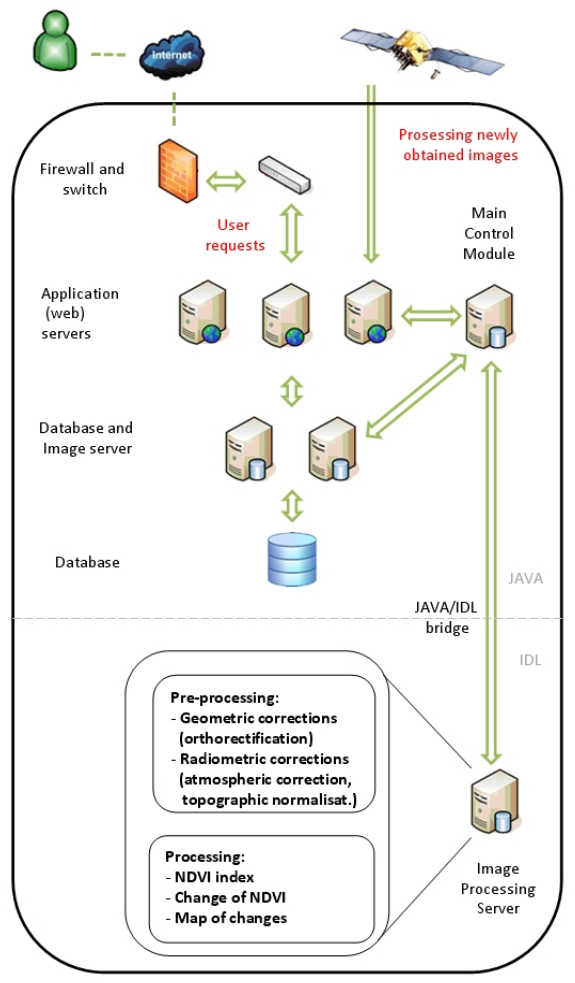
Figure 2. STORM processing chain system architecture.